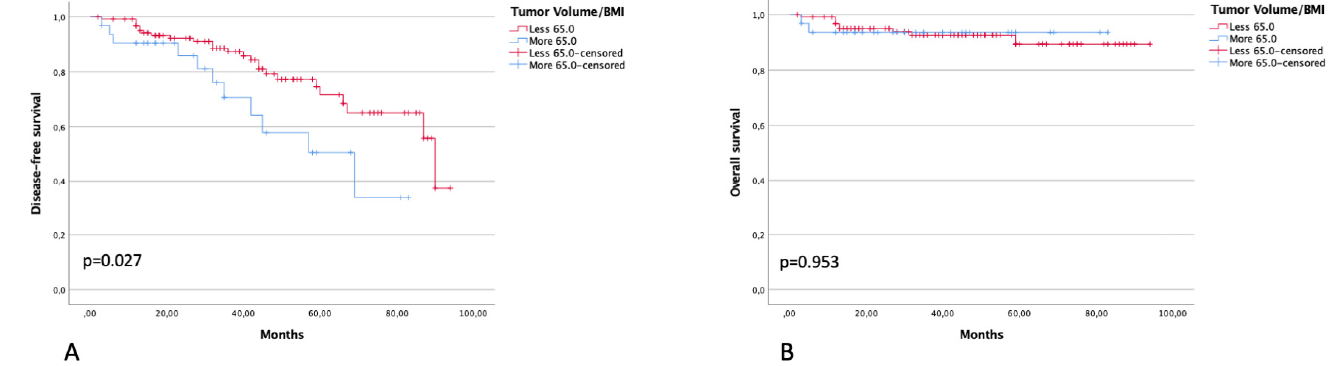
Figure 4. DFS ( A ) and OS ( B ) in patients with a ratio between tumor volume at US and BMI of ≤ 65